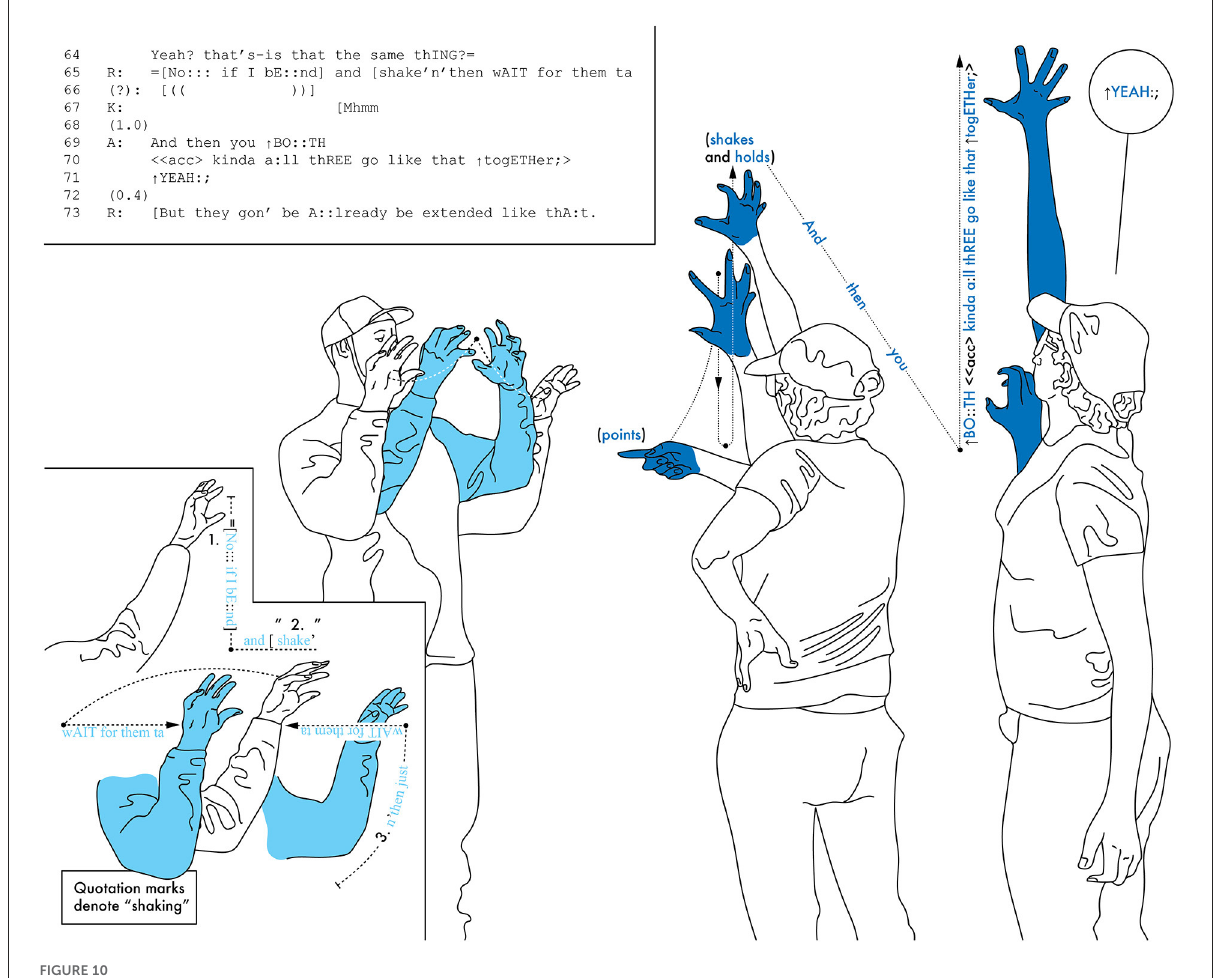
FIGURE10 Transcript